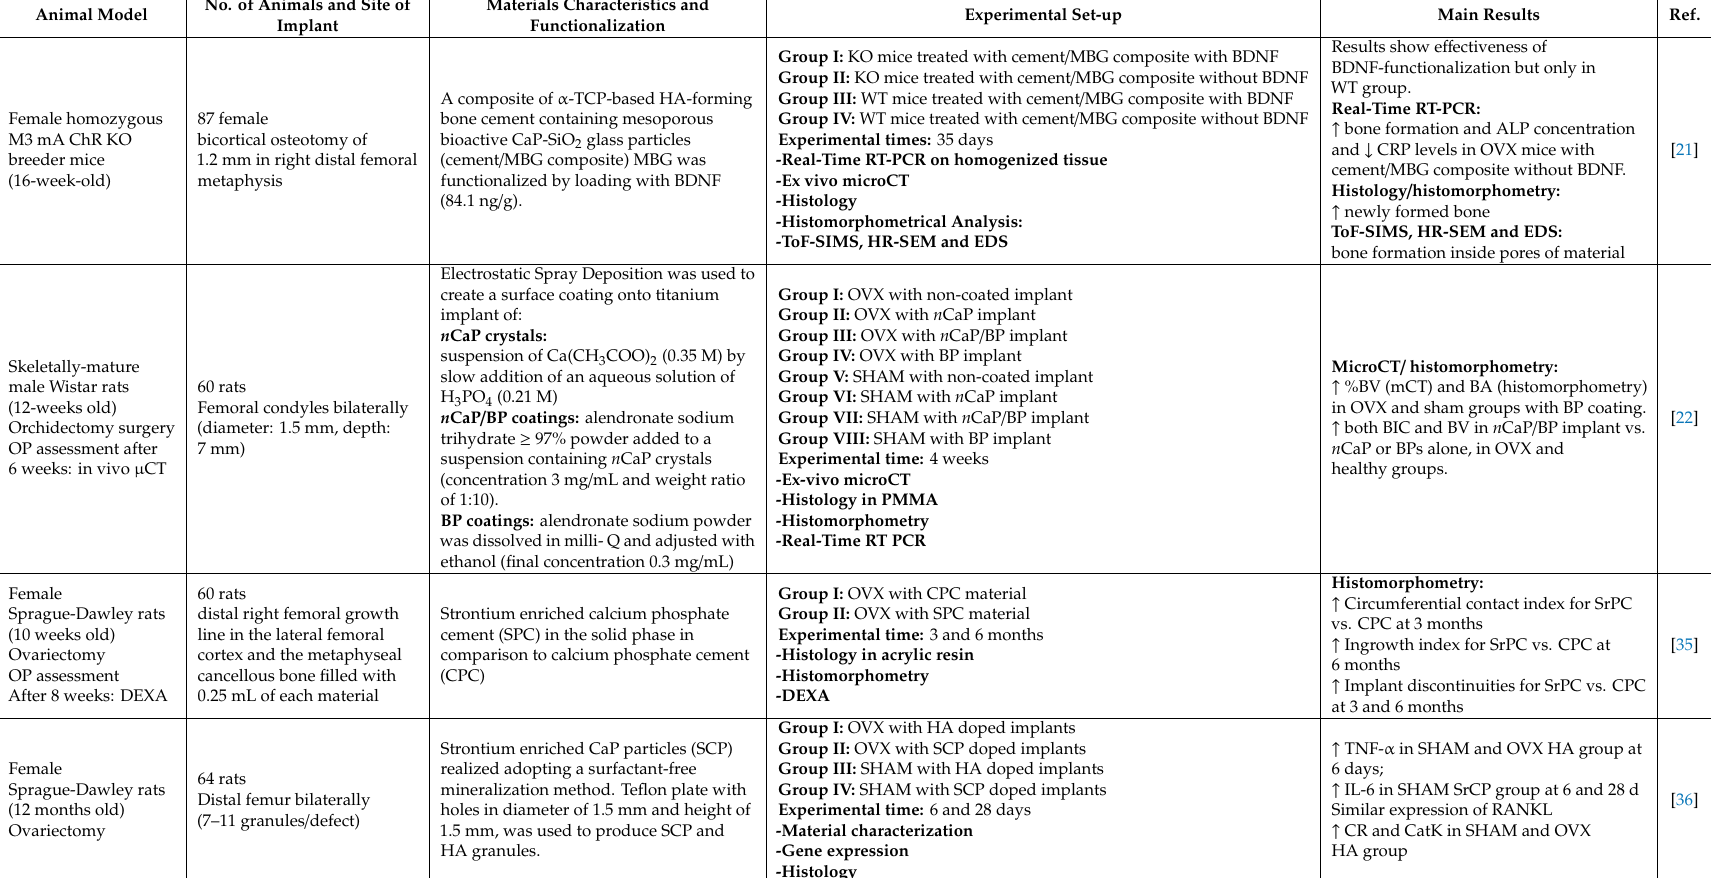
Table A1. Data extraction from small animal models (mouse and rat)